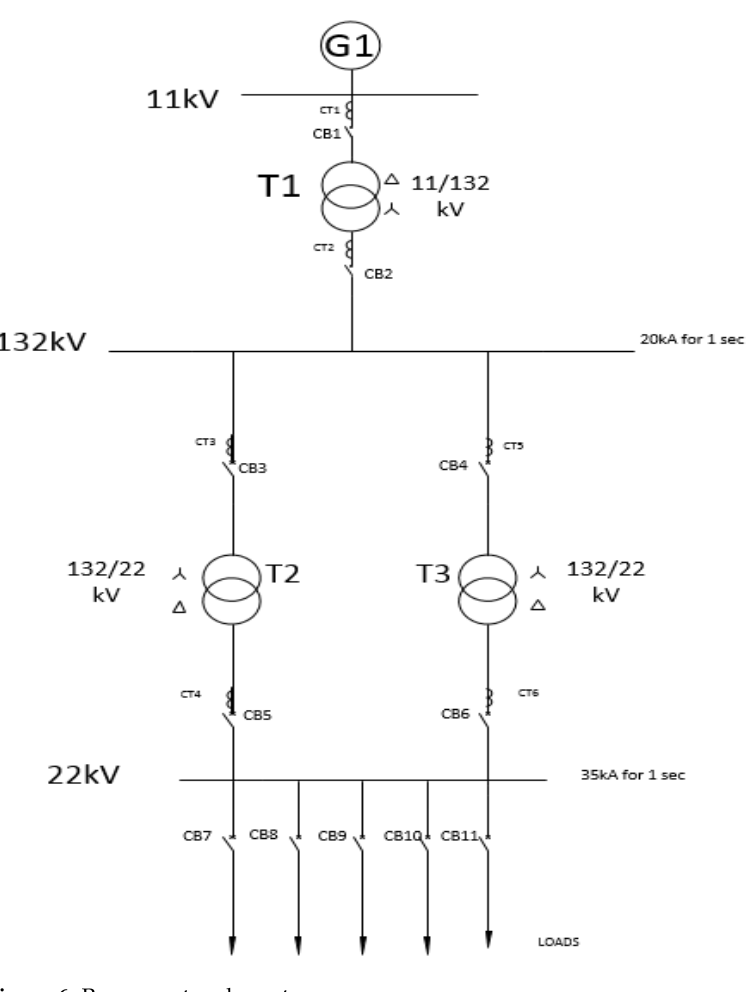
Figure 6. Power system